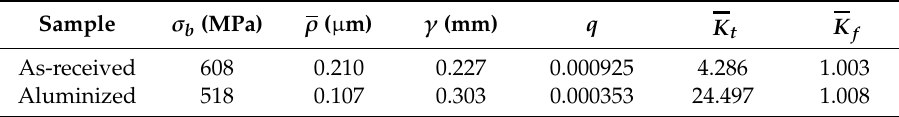
Table 6. Derivation statistics for as-received sample and aluminized